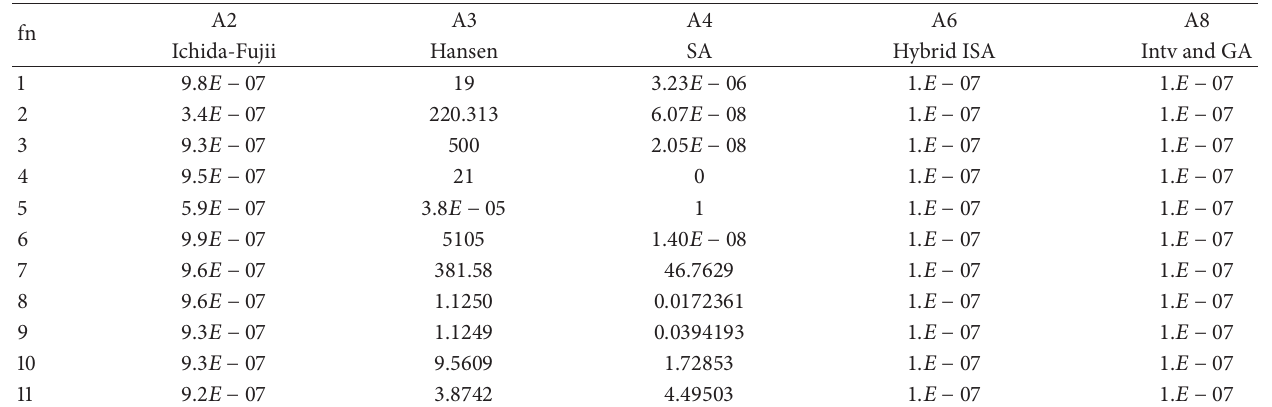
Table 6: The value of 𝑓𝑏𝑒𝑠𝑡 of A2, A3, A4, A6, and A8 for 𝑛 = 20